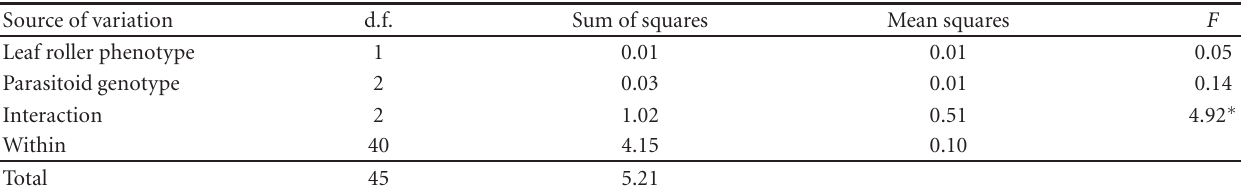
Table 3: Results of two-way ANOVA on the parasitoid femur lengths variation in dependence from the parasitoid two-locus genotype (number of heterozygous loci) and the host insect pupa coloring (see Figure 6). Source of variation